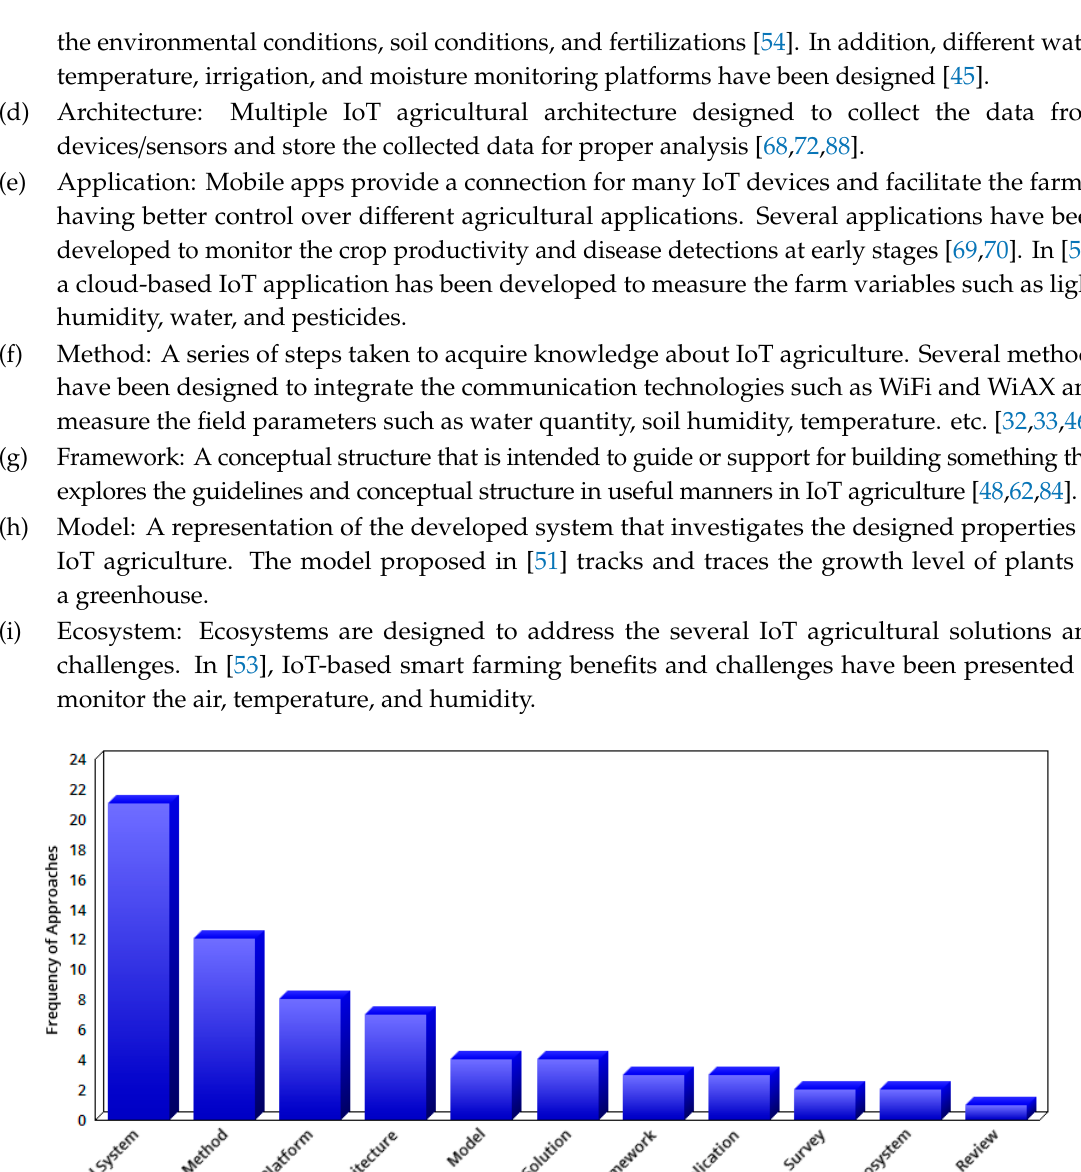
Figure 4. Application Domains. 4.1.5. Assessment of RQ5: What Are the Major Focuses of the Selected Studies? The